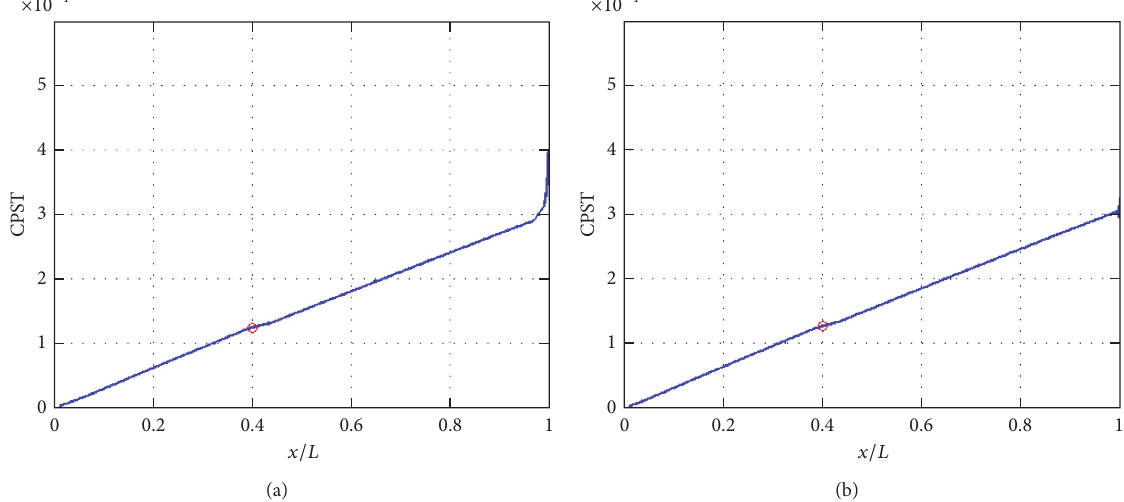
Figure 22: CPST of different sensor location scenarios using acceleration responses with damaged level is 10%, mass is 200 Kg, and velocity is 1m/s: (a) sensor location is 𝐿 𝑠 = 0.25 and (b) sensor location is 𝐿 𝑠 = 0.75